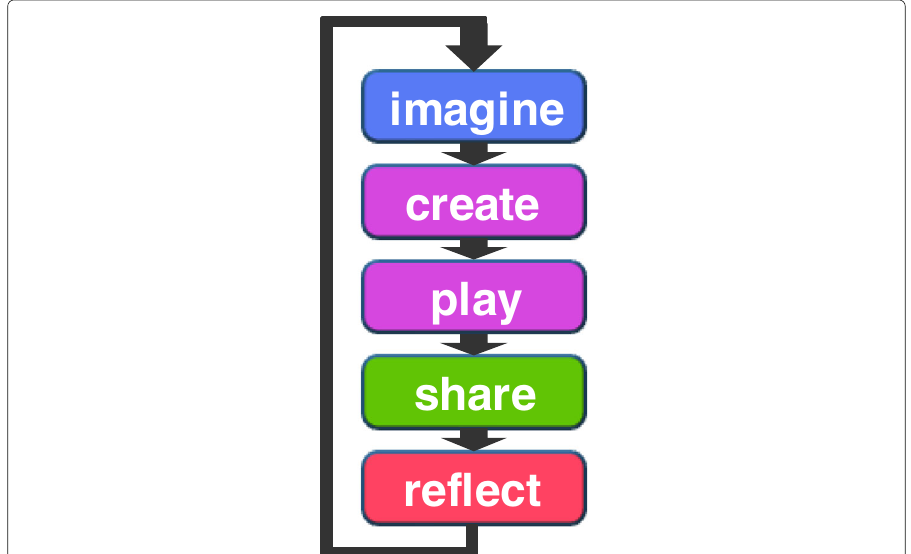
Fig. 2 Creative thinking development